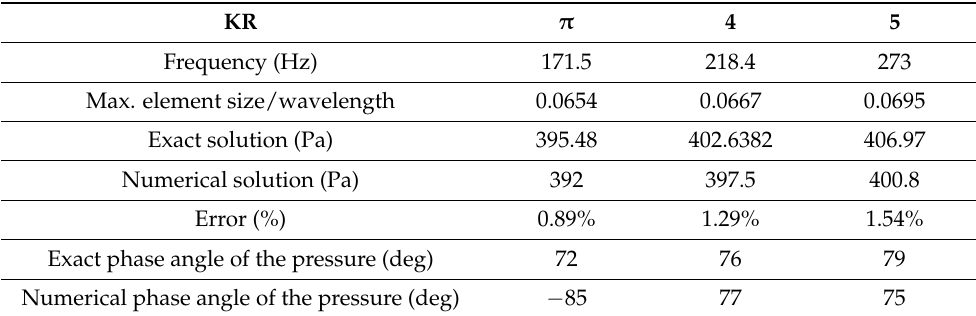
Table 2. A comparison between the analytical and numerical